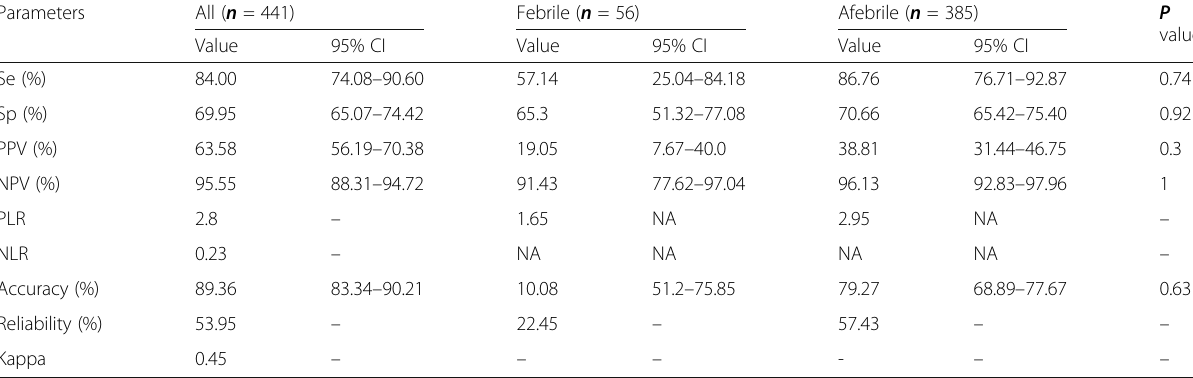
Table 4 Diagnostic performances of Cyscope® FM with regard to clinical status